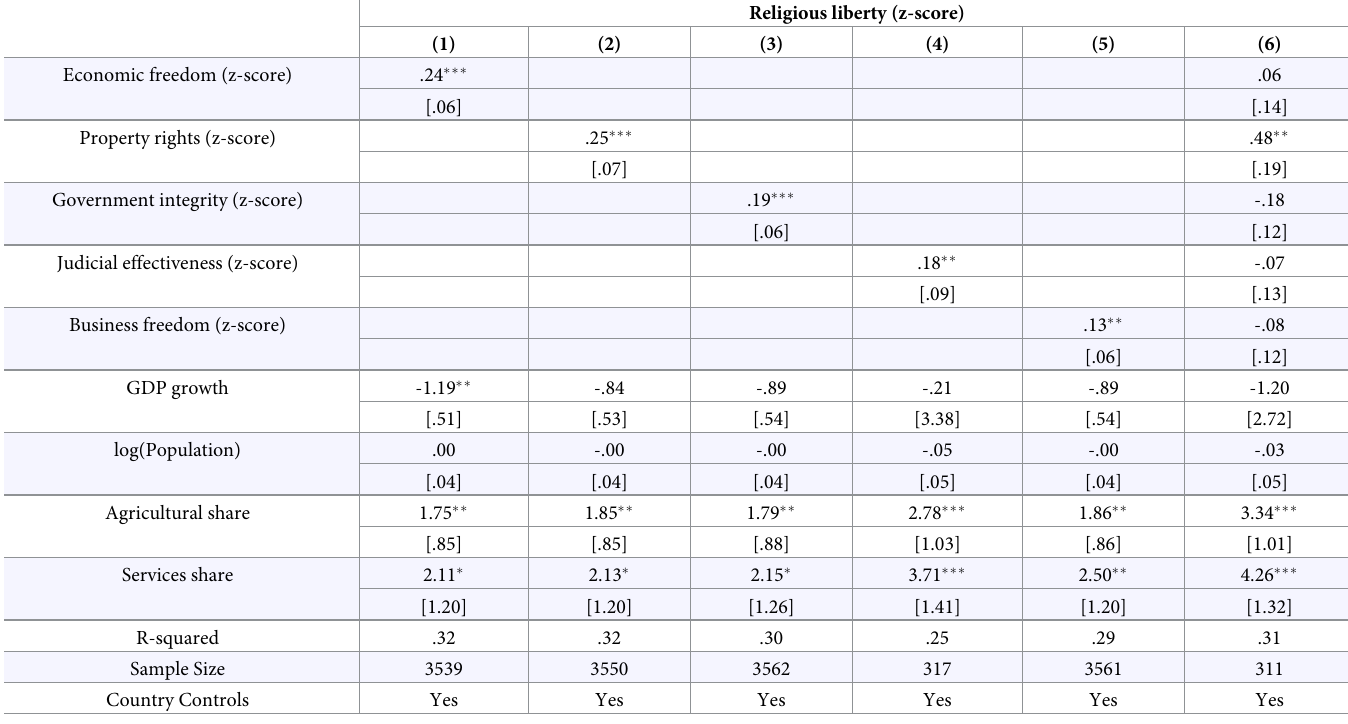
Table 3. Religious liberty and economic freedom,